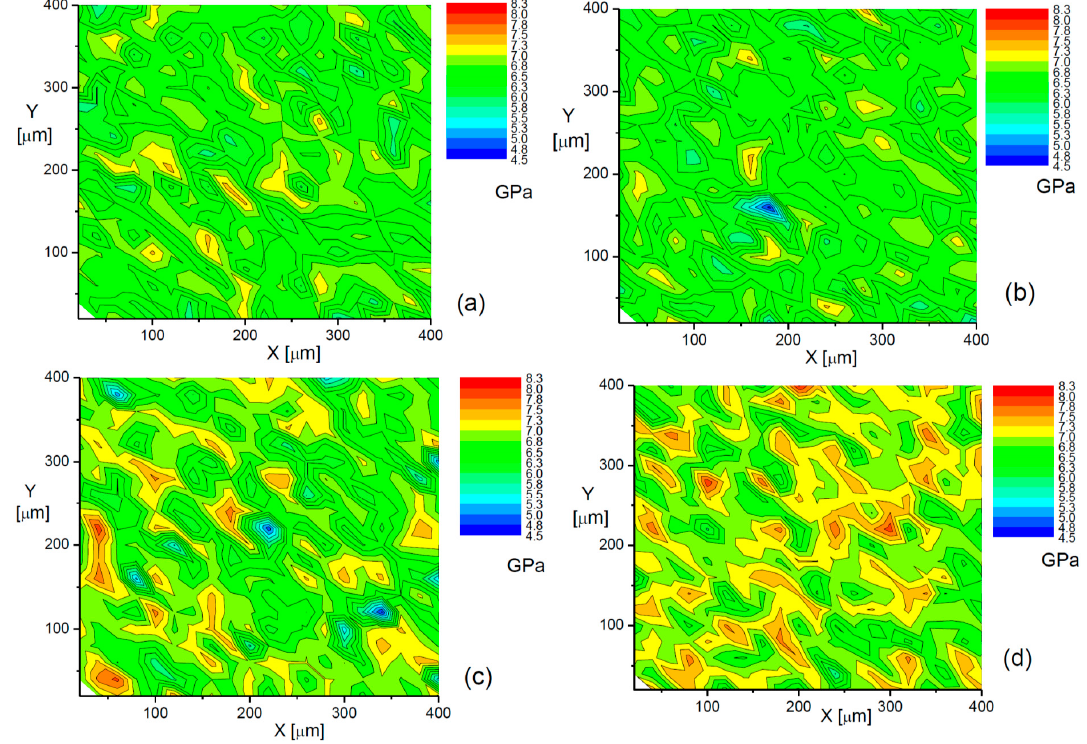
Figure 3. ( a , b ) Color-coded nanohardness maps of the undeformed, as-quenched state of the alloy at two di ff erent locations of the specimen. ( c , d ) Color-coded nanohardness maps of the specimen plastically strained to ε = 0.03, at two di ff erent locations.